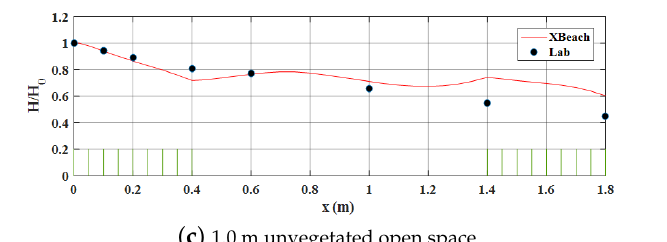
Figure 12. Normalized wave height across the model vegetation with different width of unvegetated open space in the middle of the vegetated bed. (a) 0.2 m open space. (b) 0.6 m open space. (c) 1.0 m open space. Symbols in all panels show the same set of laboratory measurements employing a whole 1.8 m wide vegetation bed, which is the identical case illustrated in Figure 11a. Line: numerical results with the of C D calculated explicitly by (6). Vertical bars at the bottom are plotted to indicate the location of the vegetation patch and do not reflect the real stem